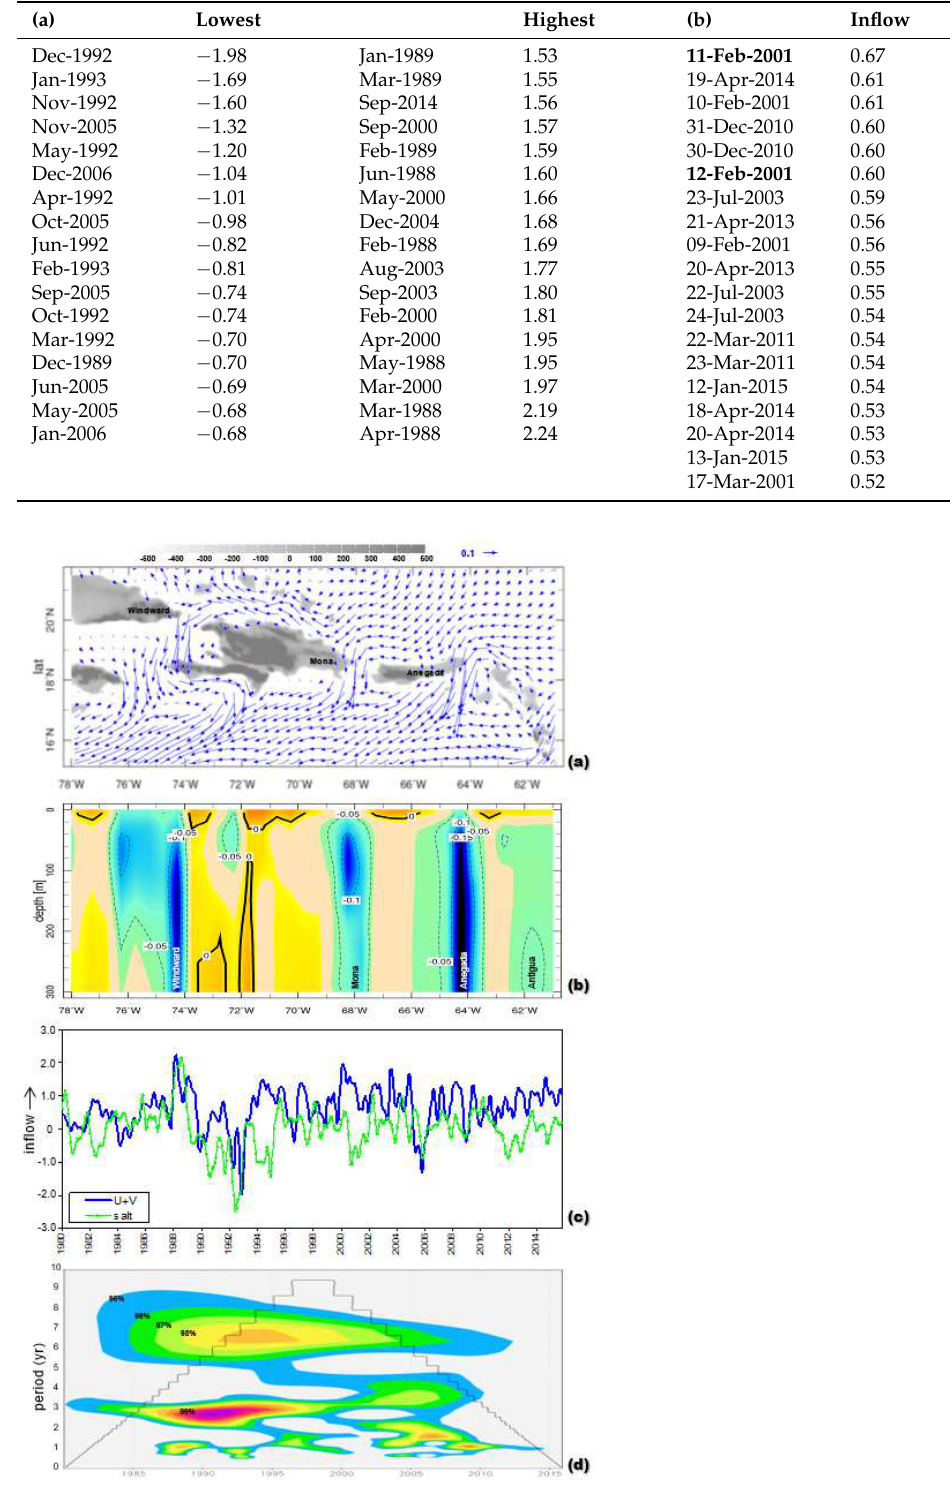
Figure 2. ( a ) EOF mode-1 of 5–200 m U and V current vectors with elevation > −500 m grey-shaded, ( b ) depth section of mean minimum V currents over 17.5–19.5° N (blue southward, yellow northward, m/s), ( c ) monthly EOF time-score representing inflow + (blue) and 1–100 m salinity departures, and ( d ) wavelet spectral energy of EOF time-score shaded from 95% (blue) to 99% (red) confidence.